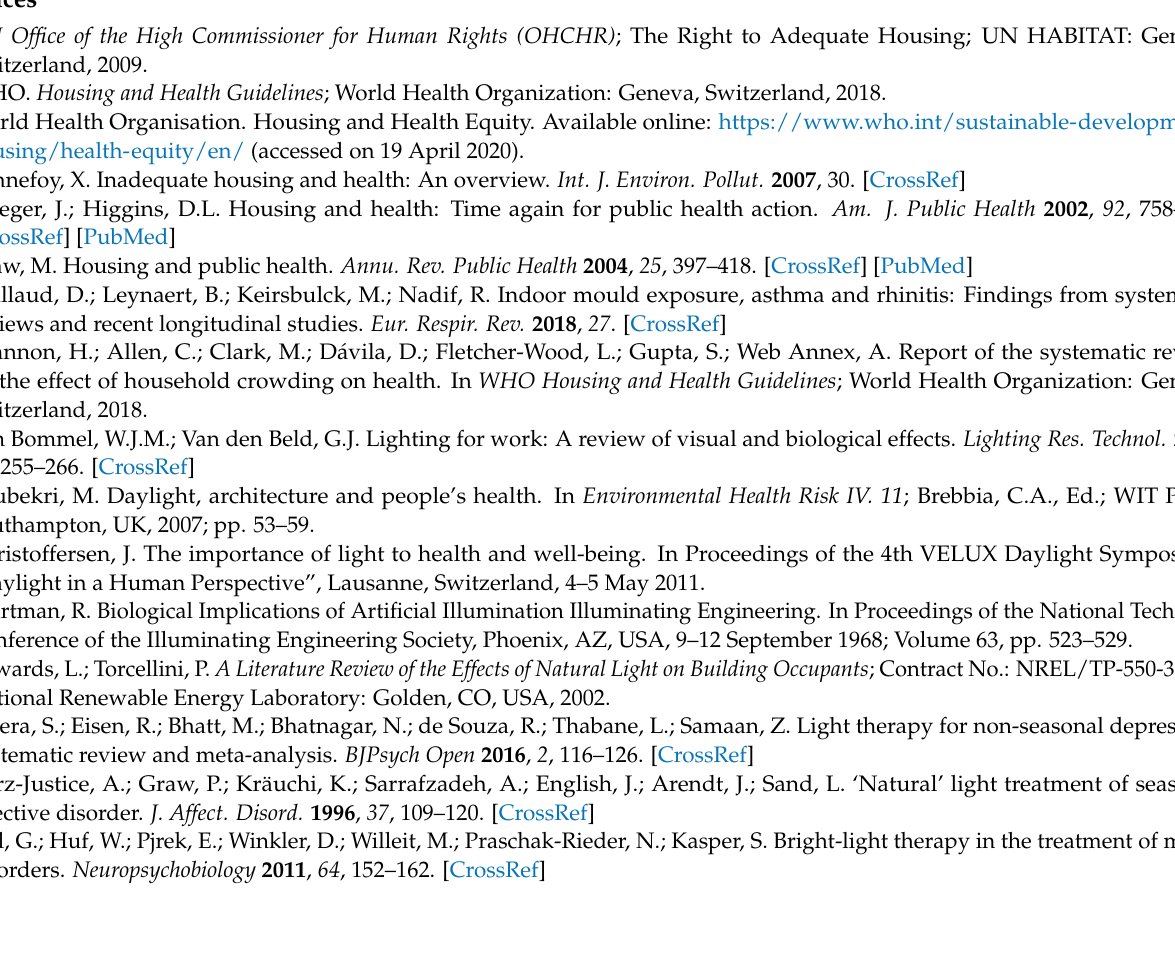
Table S2: Quality assessment score using the Newcastle-Ottawa